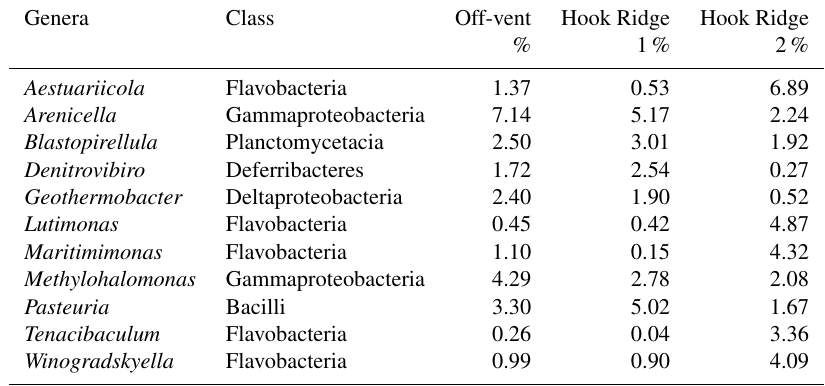
Table 3. Most dominant bacterial genera (covering the top five at each site), with percent of total sequenced reads. Genera Class Off-vent Hook Ridge Hook Ridge % 1% 2% Aestuariicola Flavobacteria Arenicella Gammaproteobacteria Blastopirellula